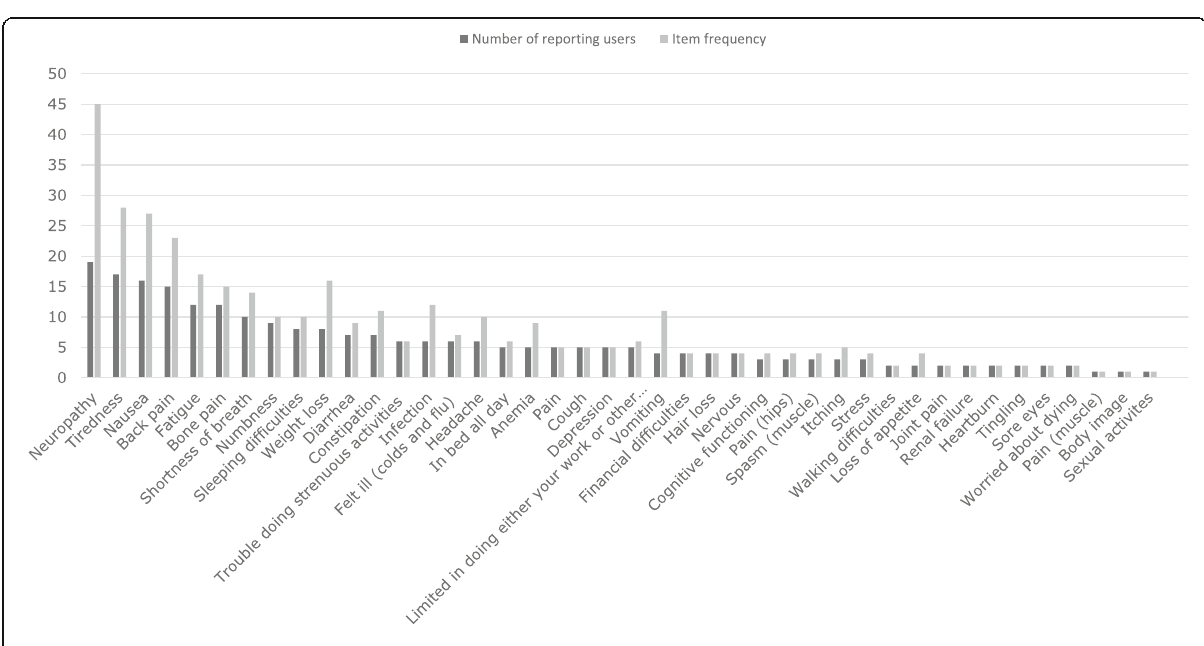
Fig. 4 Number of Patients and Frequency of Symptoms and Impacts Reported by Patients. Number of patients reported on an absolute count scale and the frequency of times the symptom/impact was discussed reported as percent